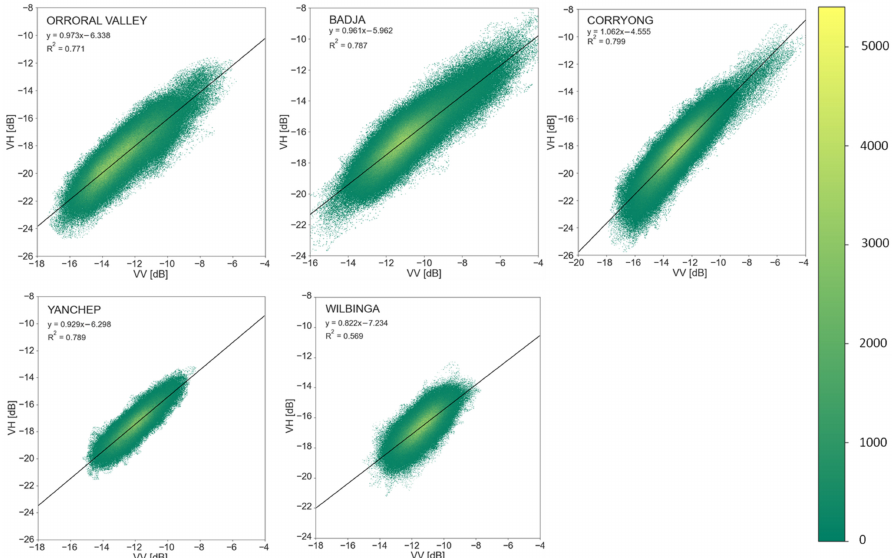
Figure 3. Density plots and vegetation lines from the backscatter values in the VV and VH bands from Sentinel-1 for the study areas Orroral Valley (Australian Capital Territory), Badja (New South Wales), Corryong (Victoria), Yanchep (Western Australia), and Wilbinga (Western Australia). Figure 4a illustrates an example of the (non-burnt) vegetation line (black) and the displaced burnt-area lines (colored) for the Orroral Valley wildfire (ACT) using backscatter values from Sentinel-1. The vegetation line (black) obtained from the paired backscatter values over the forest areas from the pre-fire period represents undisturbed healthy vege- tation (Figure 4a). The disturbance caused by wildfires, shifted the post-fire backscatter values away from the reference (vegetation) line, indicating the depletion of the forest fuel or change in the vegetation structure due to wildfire impact (Figure 4a). For the immediate post-fire period, the displaced isolines formed from the post-fire backscatter values of Sentinel-1 showed a clear, negative displacement from the vegetation line (Figure 4a). This is in accordance with the hypothesis (Figure 1B,C).